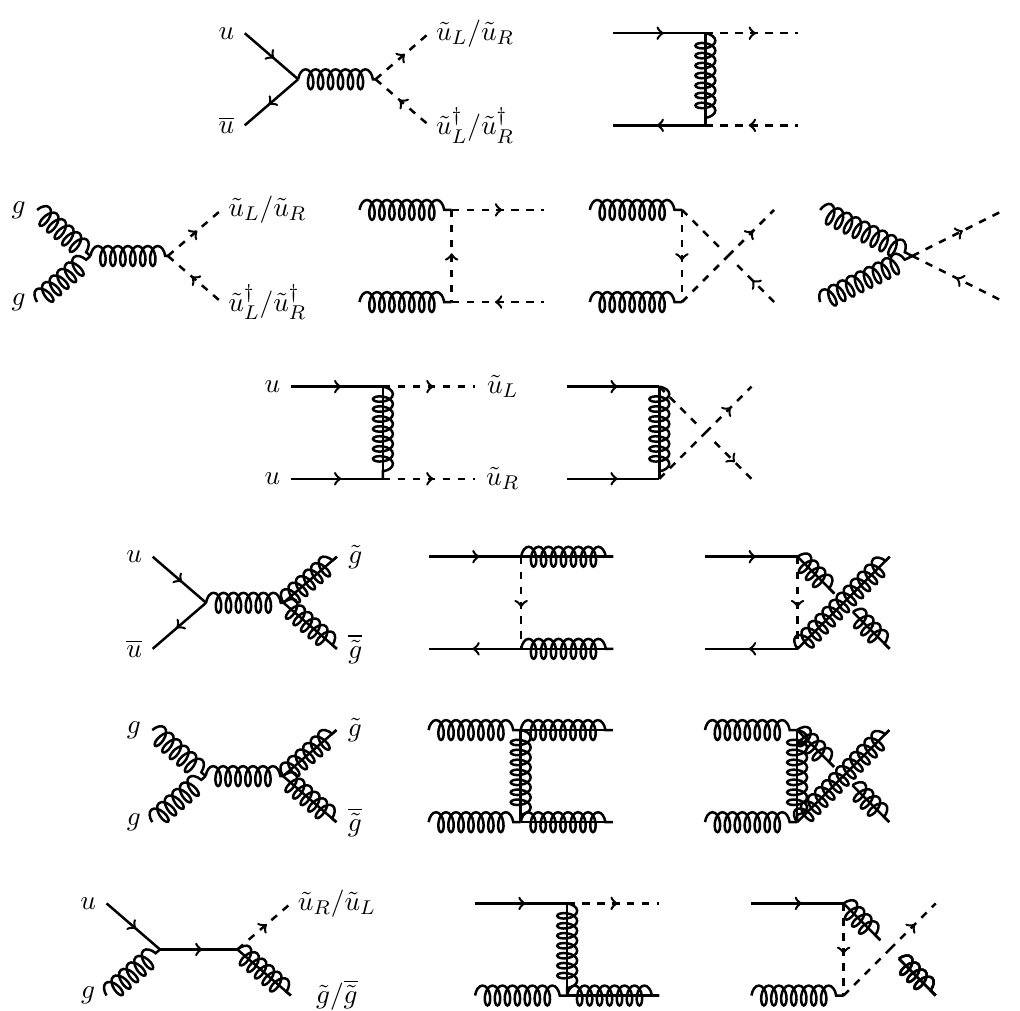
Figure 1. Tree-level diagrams for squark and gluino production in the MRSSM. For simplicity, only one quark (cid:13)avour is shown. In the third and last line, also a charge conjugated process